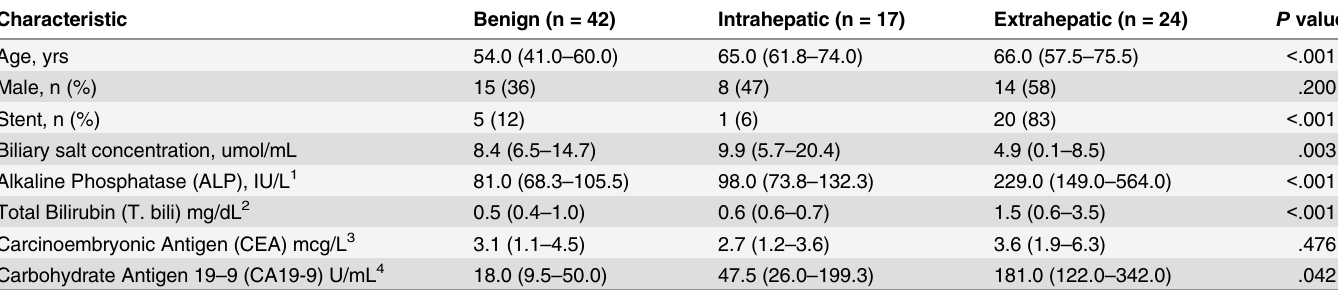
Table 1. Basic demographics of patients with benign and malignant disease.